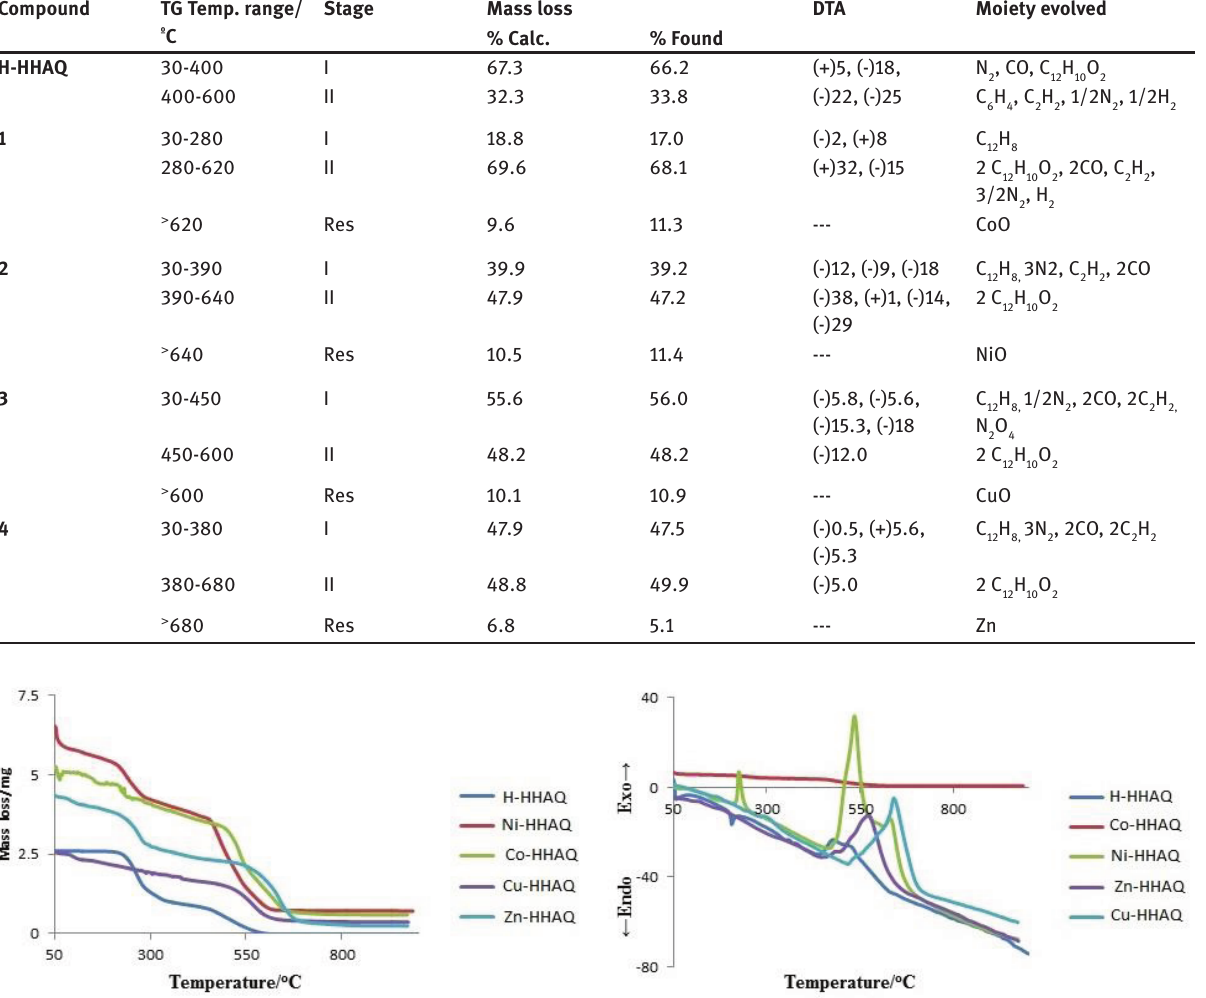
Scheme 4: Thermal degradation of